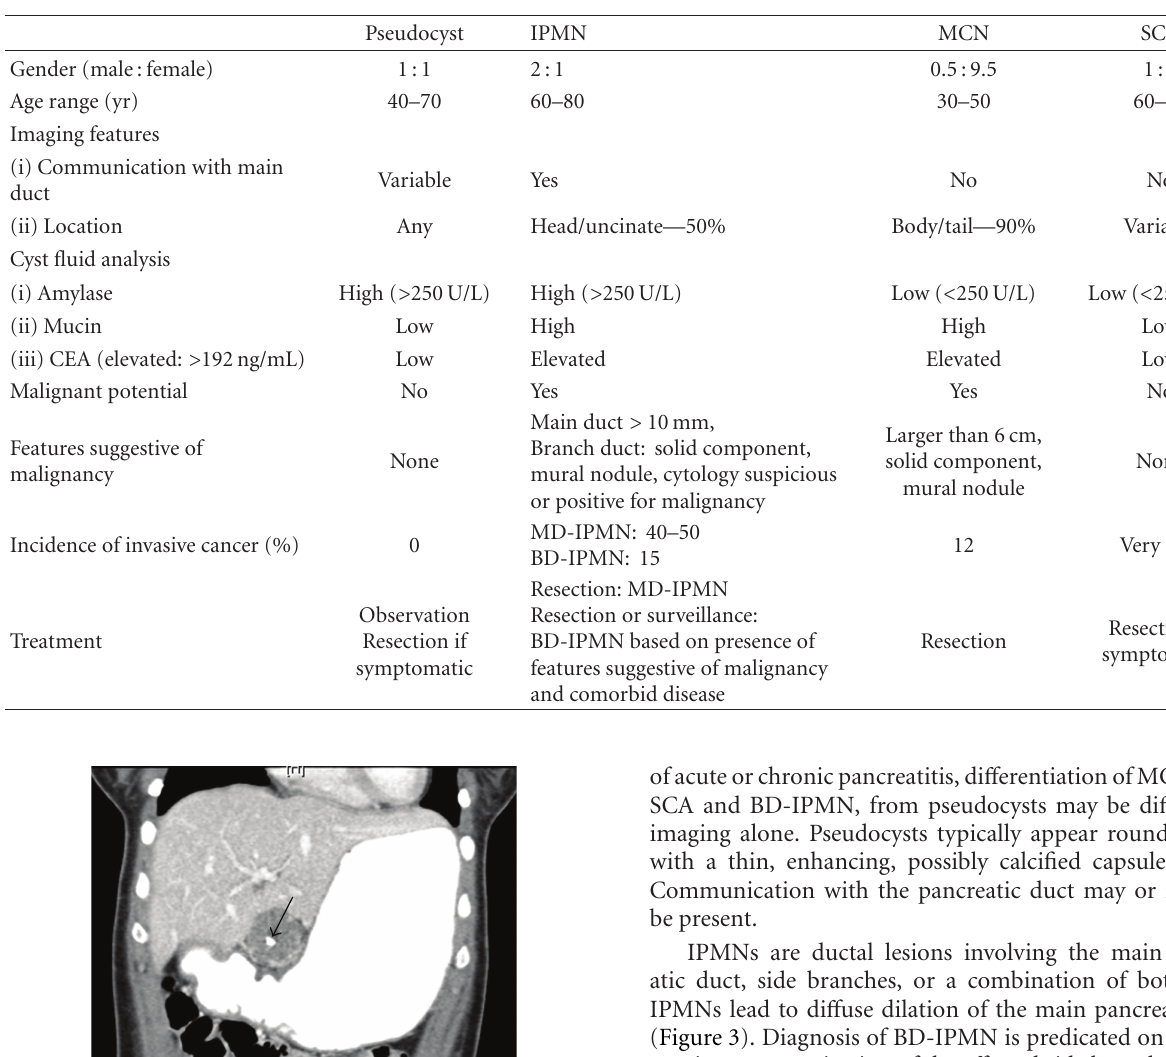
Table 1: Characteristics of common pancreatic cysts.